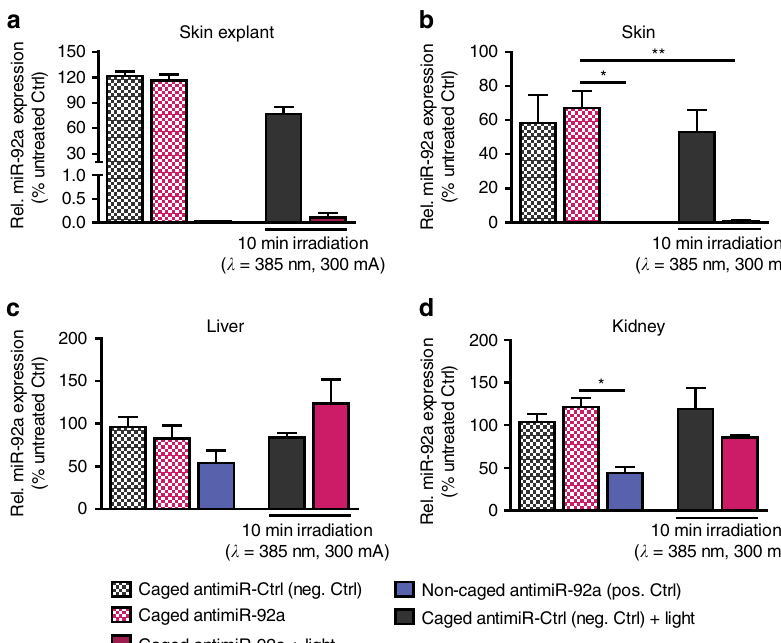
Figure 1 | Efficient miR-92a downregulation in the skin upon treatment with caged antimiR-92a. ( a ) miR-92a expression level quantified by real-time PCR in skin explants after 48h of intradermal injection with different antimiRs as indicated ± light activation ex vivo . n ¼ 2 explants per treatment, isolated from two different mice. qPCR analysis for miR-92a levels in the skin ( b ), liver ( c ) and kidney ( d ) upon i.d. injection of different antimiRs as indicated ± light activation in vivo . RNA was isolated after 48h of injection. n ¼ 4 different animals per group. Data are expressed as means ± s.e.m. Significance of difference was analysed using analysis of variance one-way test analysis with Newman–Keuls Multiple Comparison Test. ** P o 0.01, * P o